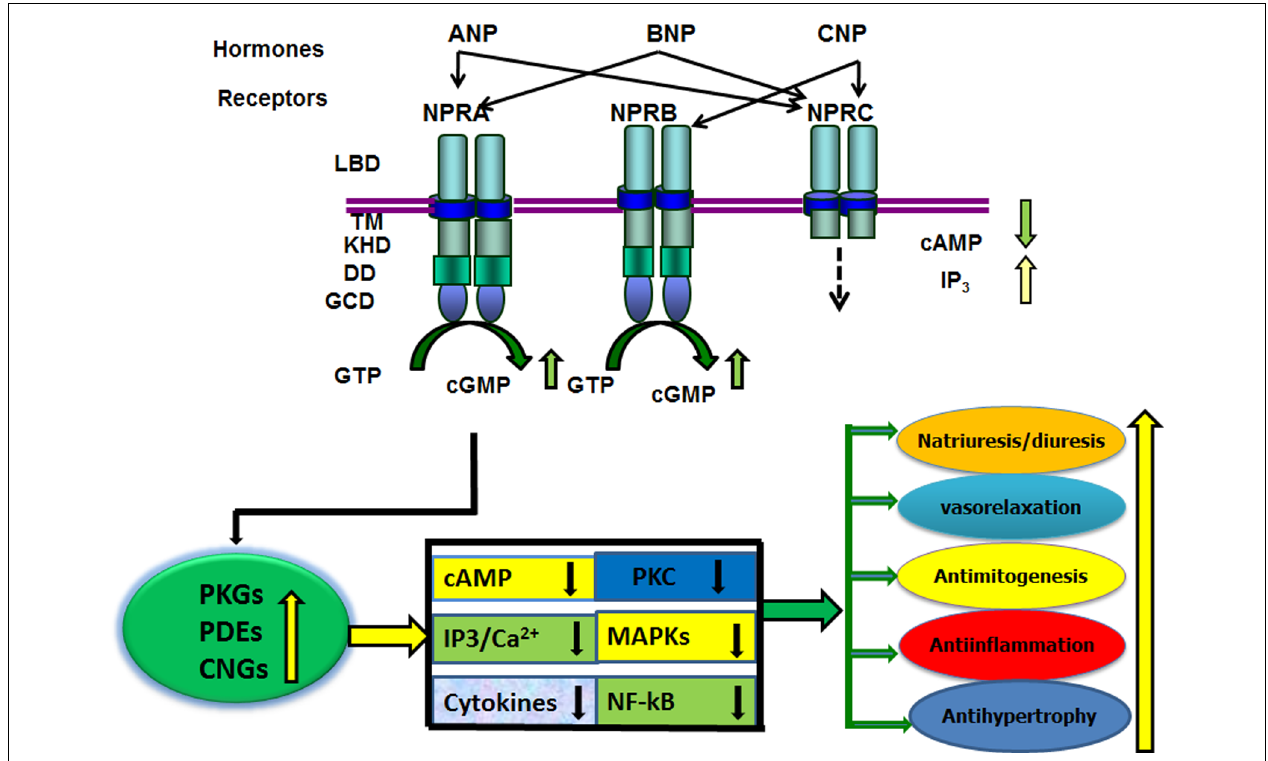
FIGURE 1 | Diagram represents the ligand specificity and physiological function(s) of GC-A/NPRA. The ligand-binding to NPRA generates second messenger cGMP from the hydrolysis of GTP. An increased level of intracellular cGMP is produced, which activates three known cGMP effecter molecules namely; cGMP-dependent protein kinases (PKGs), cGMP-dependent phosphodiesterases (PDEs), and cGMP-dependent ion-gated channels (CNGs).The ANP/NPRA/cGMP signaling may antagonize a number of pathways including; intracellular formation of cAMP, Ca 2 + , IP 3;